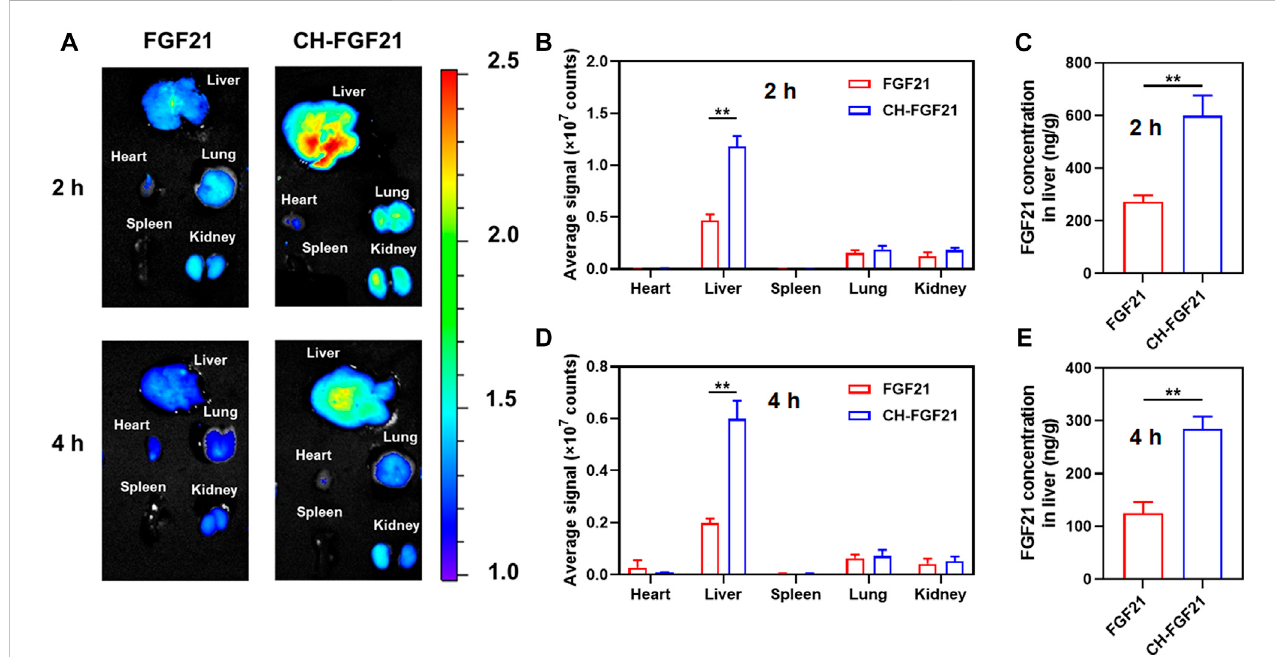
FIGURE 4 Biodistribution of CH-FGF21. (A) Fluorescence images of various organs in mice suffering from acute liver injury (ALI) after intravenous administration of FGF21 or CH-FGF21. Quantitative analysis of fl uorescence intensity in the major organs of mice (B) 2 h and (D) 4 h after injection. FGF21 level in the liver of mice (C) 2 h and (E) 4 h after injection. Data are the mean ± SD ( n = 8). * p ≤ .05, ** p ≤